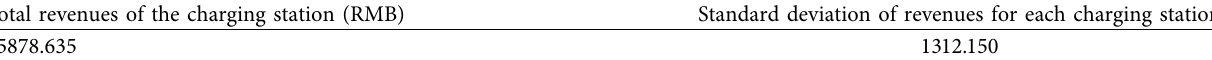
Table 6: Total revenues of charging stations based on large-scale EV path planning.